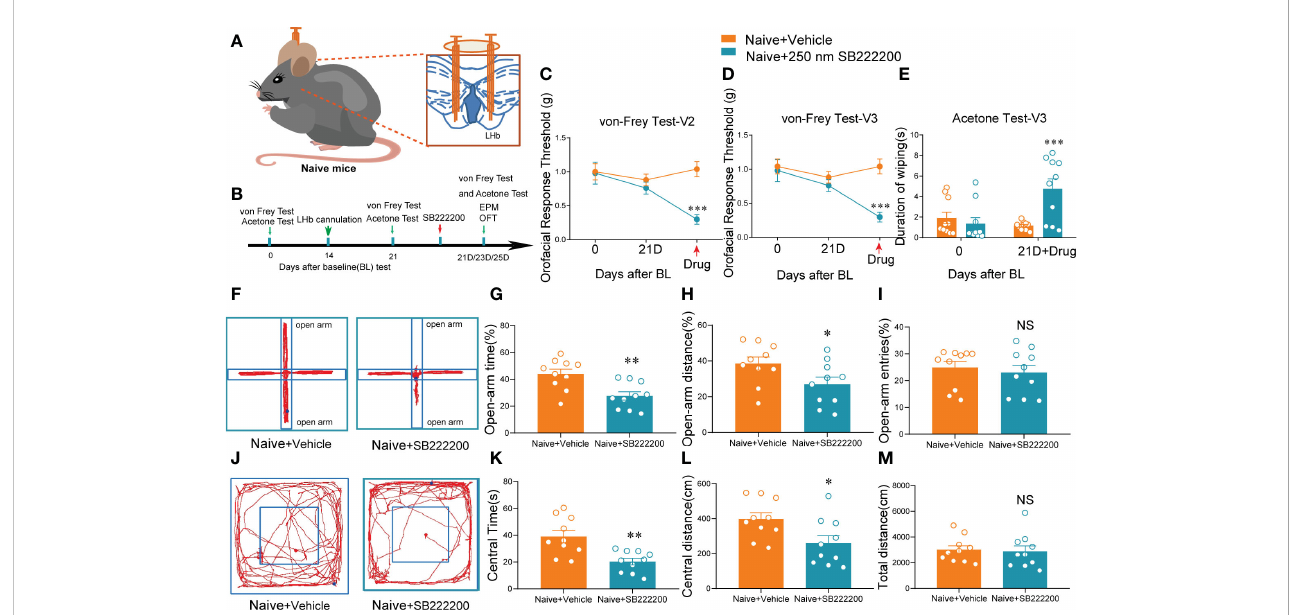
FIGURE 5 Bilateral NK3R antagonist SB222200 injection into the LHb induced orofacial allodynia and anxiety-like behaviors in naive mice. (A) Schematic of bilateral cannula implantation in the LHb of naive mice. (B) The time schedule of behavioral testing, cannulation, and drug administration. (C – E) Bilateral SB222200 injection into the LHb induced allodynia in the V2 skin (C) and V3 skin (D) and secondary cold allodynia in the V3 skin (E) (***p < 0.001 vs. the Naive+vehicle group, n = 10 mice per group). (F) Typical trajectories in the EPM. (G – I) Bilateral SB222200 injection into the LHb decreased the percent of open-arm time (G) , distance (H) , and entries (I) (*p < 0.05, **p < 0.01, vs. the Naive+vehicle group, n = 10 mice per group). (J) Typical trajectories in the OFT. (K – M) Bilateral SB222200 injection into the LHb decreased the central time (K) and central distance (L) while the total distance (M) remained the same (*p < 0.05, **p < 0.01, vs. the Naive+vehicle group, n = 10 mice per